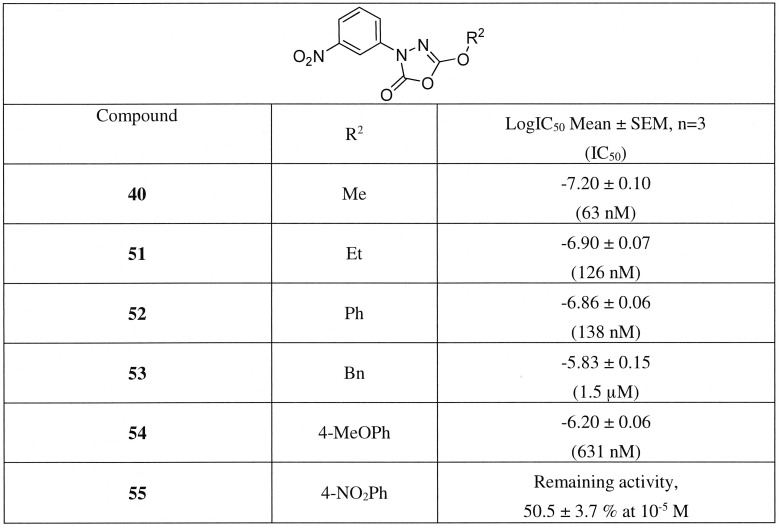
Inhibition of hBAT5 by 5-alkoxy and phenoxy substituted 3-(3-nitrophenyl)-1,3,4-oxadiazol-2(3H)-ones 40, 51–55.Lysates of hBAT5-HEK293 cells were treated for 30 min with the inhibitors after which glycerol liberated from 1-LG hydrolysis (25 µM final concentration) was kinetically monitored for 90 min. Inhibitor dose–response curves and IC50 values derived thereof were calculated from non-linear regressions using GraphPad Prism 5.0 for Windows. Values are mean ± SEM from three independent experiments using lysates from one bacth of transfection.